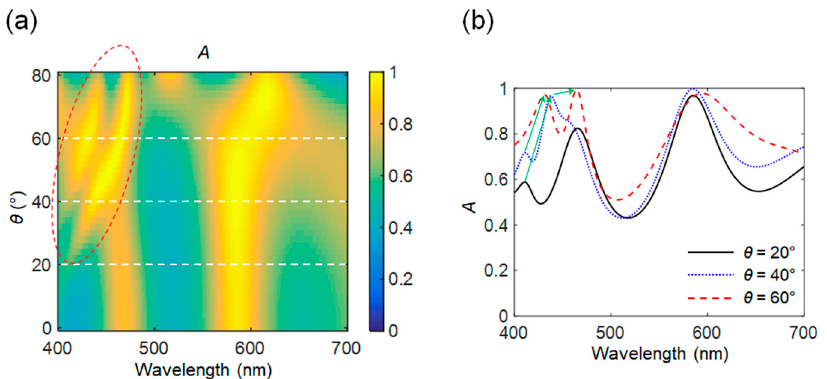
Figure 6. ( a ) The spectral absorption map with respect to the incident angle up to 80°. The structural parameters are the same as those used in Figure 5 ( p = 160 nm, w = 40 nm, t g = 30 nm, and t d = 270 nm). Absorption modes generated at oblique incidence are marked with the dashed red-colored oval. ( b ) Absorption profiles for three incident angles of θ = 20, 40, and 60°. Absorption peak shifts of new modes with increasing incidence angle are indicated by green-colored arrows.